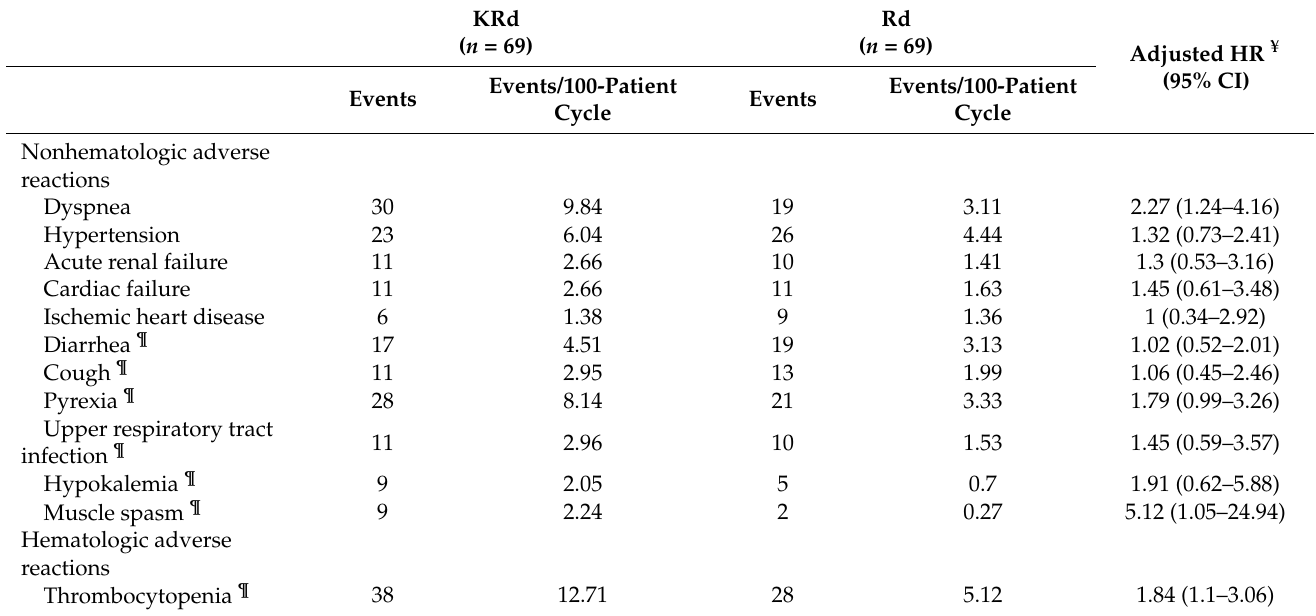
Table 3. Hazard ratios for each adverse